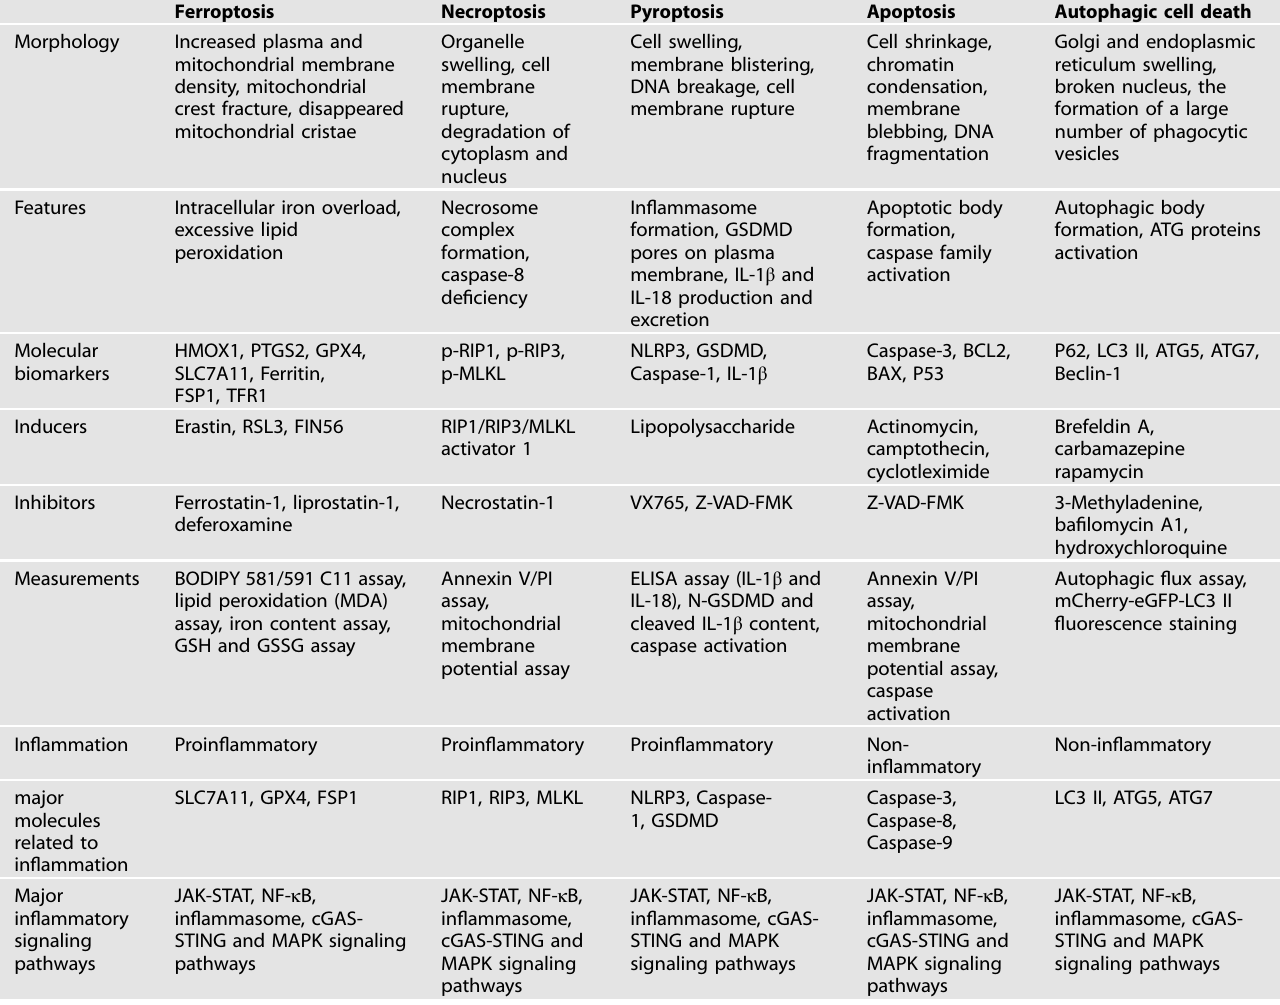
Table 2. Comparison between non-in fl ammatory cell death and proin fl ammatory cell